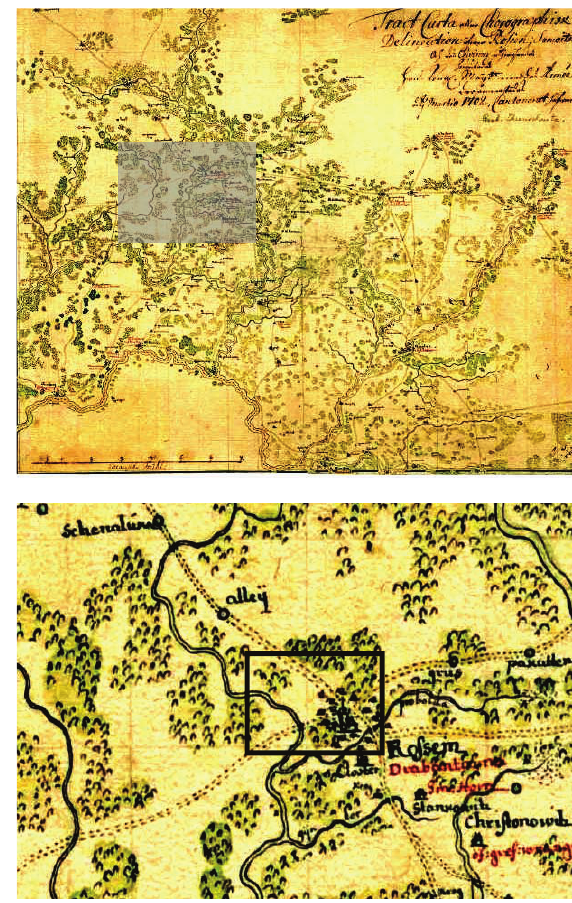
Fig. 10. Swedish cartographer‘s map of Žemaitija